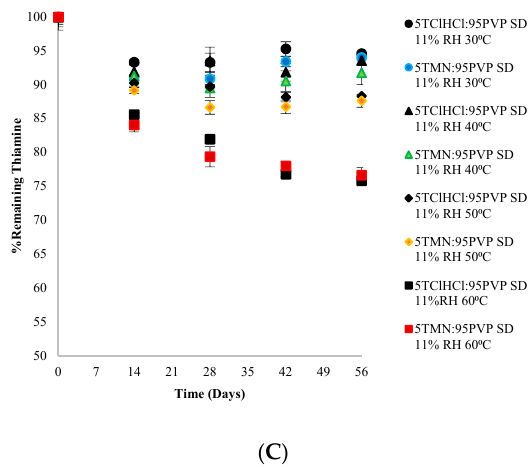
Figure 8. Comparison of chemical stability of TMN and TClHCl amorphous solid dispersions (SD) with 95% polymer: ( A ) SDs with 95% PVP and stored at 75% RH and 40 °C; ( B ) SDs with 95% PEC and stored at 11% RH and 30–60 °C; and ( C ) SDs with 95% PVP and stored at 11% RH and 30–60 °C.